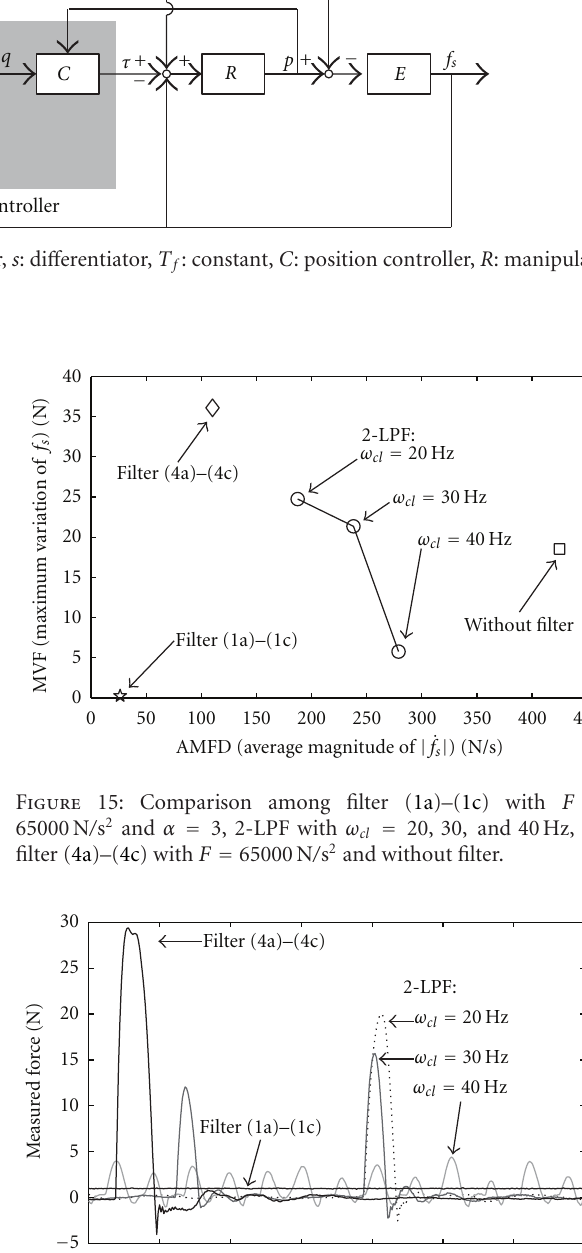
Figure 16: Typical contact force data obtained through filter (1a)– (1c) with F = 65000N / s 2 and α = 3, 2-LPF with ω cl = 20, 30, and 40Hz, and filter (4a)–(4c) with F = 65000N / s 2 . and the maximum variation of f s , which is defined as